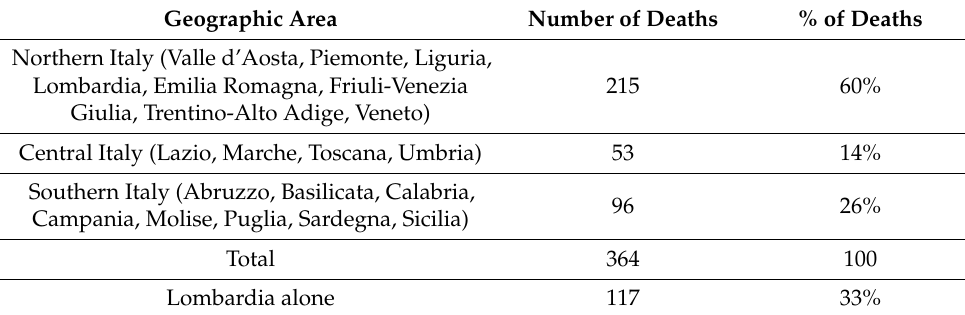
Table 3. Geographic distribution of